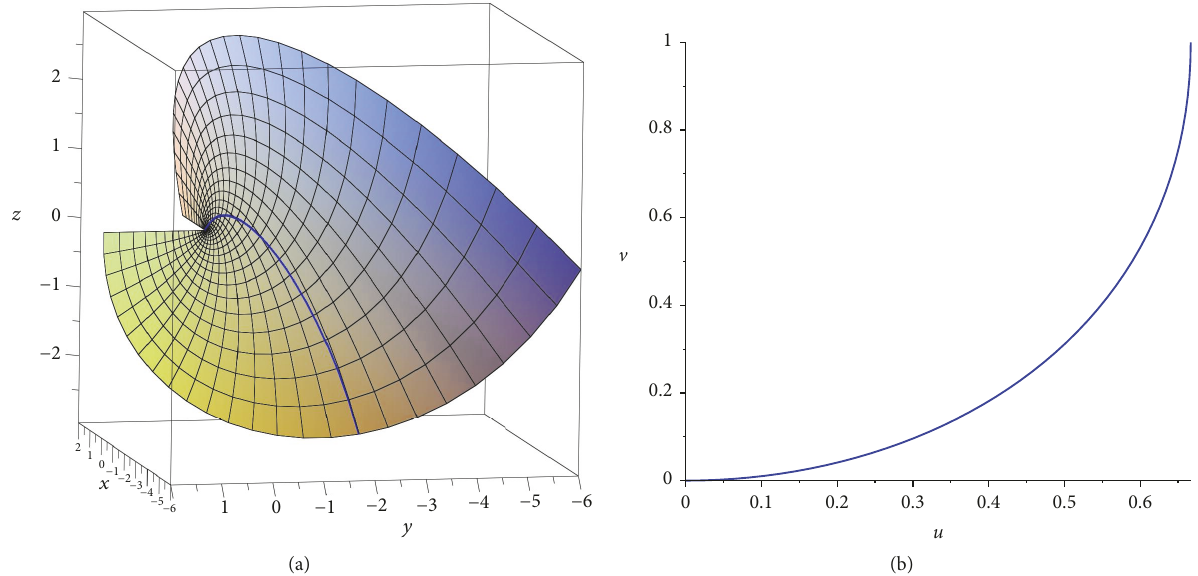
Figure 1: (a) A PH-preserving surface parameterized by P , derived in Example 3, when 0 ≤ 𝑡 ≤ 1 ; the blue curve on the surface is the image of 𝛾(𝑡) , shown in